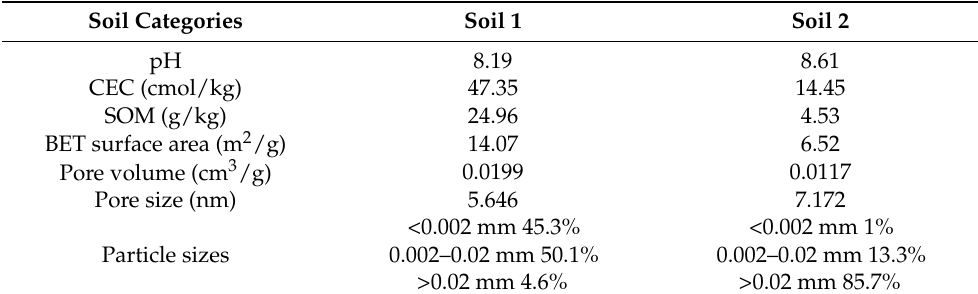
Table 1. Physical and chemical properties of the studied soil samples. Soil